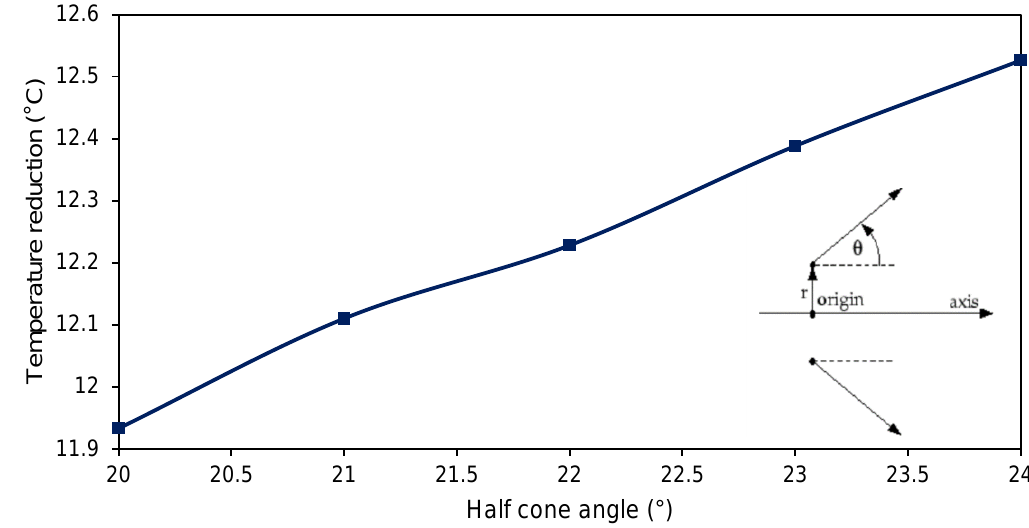
Figure 20. The influence of the spray nozzle half cone angle (θ) on the temperature reduction (ambient T = 40 °C, RH = 24.5%, U HWC = 4.4 m/s).